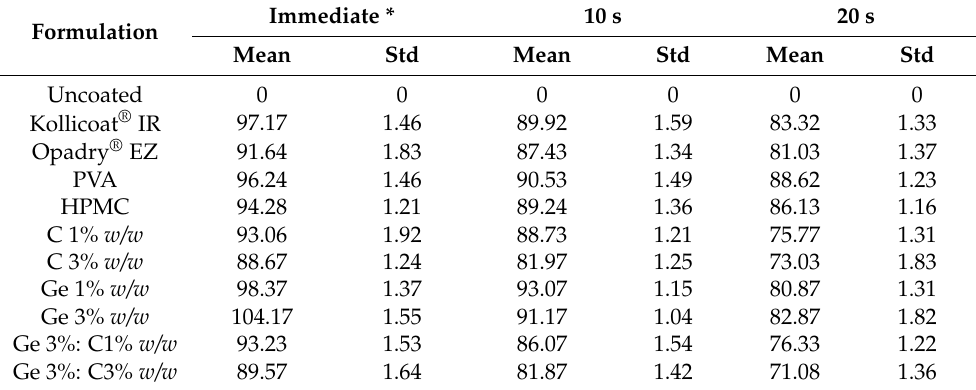
Table 2. Apparent contact angle measurements with respect to time using sessile drop technique of film-coated tablets. Values equal to and below 90 ◦ correspond to increasingly hydrophilic surfaces in contrast to values above 90 corresponding to relatively more hydrophobic surfaces (un-wetting systems). Measurements were taken in triplicate and reported as mean value ± standard deviation. * The immediate apparent contact angle was recorded as the instant stable droplet contact on